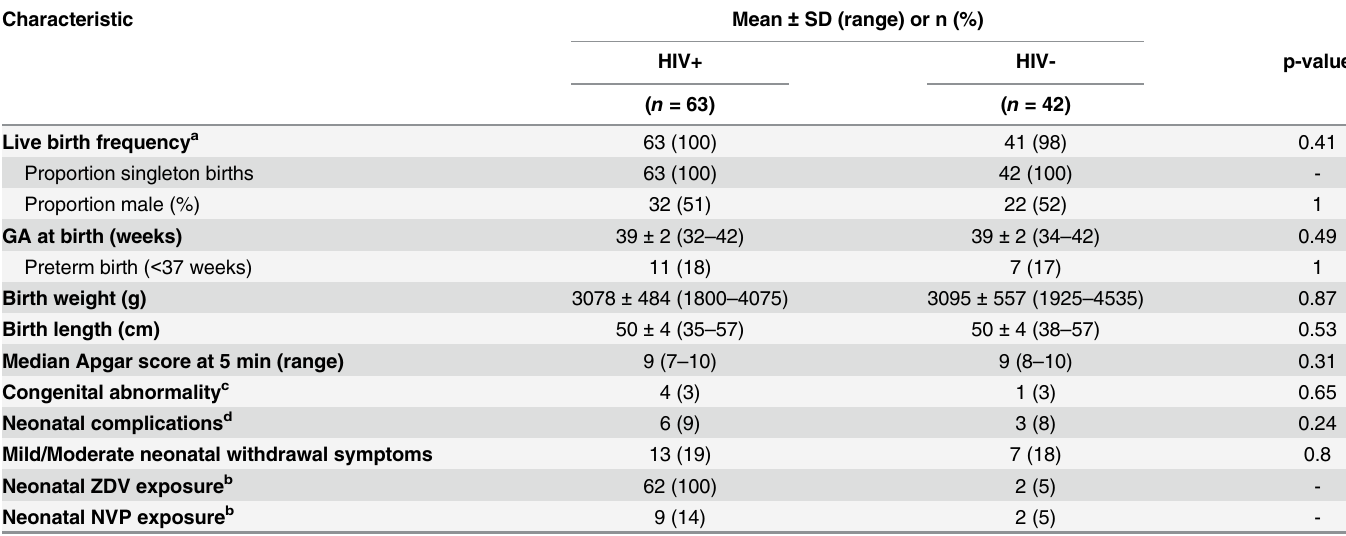
Table 4. Perinatal and neonatal outcomes for HIV+ (n = 63) and HIV- (n = 42) maternal infant pairs.